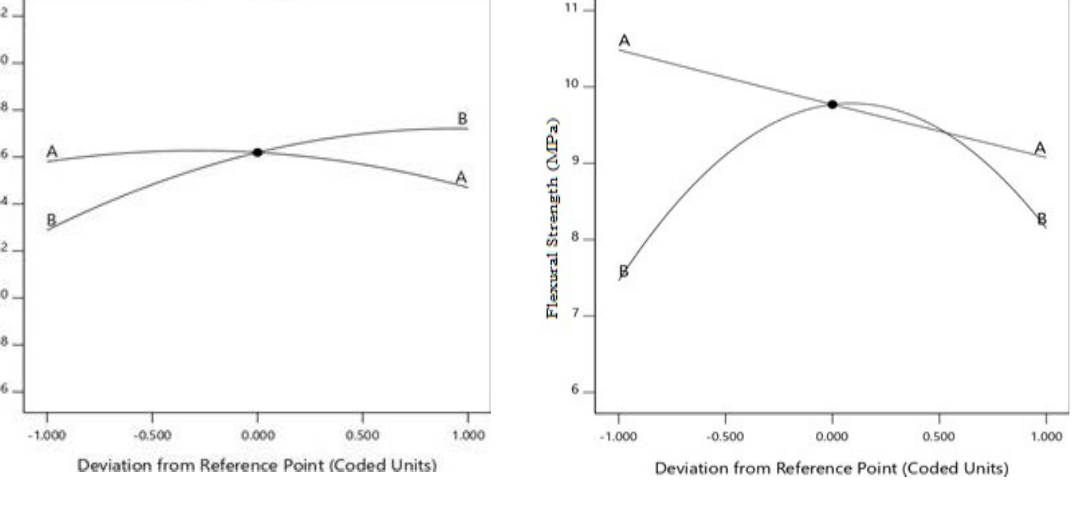
Figure 8. Normal plot versus externally studentized residuals: ( a ) 28 − day compressive strength; ( b ) 28 − day flexural strength; ( c ) 28 − day splitting tensile strength.